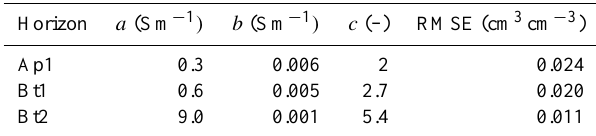
Fig. 4. EC b ( σ TDR ) and SWC ( θ TDR ) for TDR measurements real- ized in the three soil horizons in 2010 (Ap1 horizon a , Bt1 horizon b , and Bt2 horizon c ). The black curves represent the simplified Waxman and Smits model that fits the σ TDR – θ TDR couples. Table 2. Parameters for the simplified Waxman and Smits model and RMSE for each of the three soil horizons.